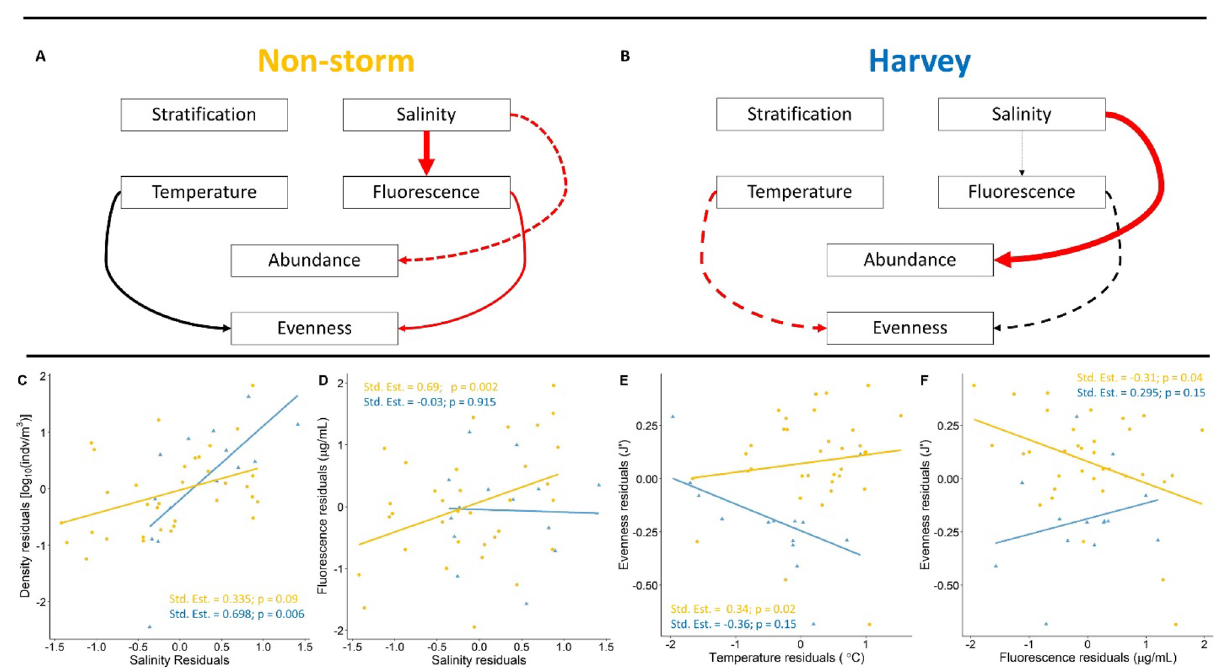
Figure 5. Multigroup PSEM of Harvey and non-storm models. Panels below break out changes in relationship highlighted by the multigroup analysis. Line color and point shape represent Harvey (blue triangles) and non- storm (yellow dots) samples. Red arrows indicate negative relationships between parameters, black arrows mean positive. Relative size of the arrows indicates magnitude of the